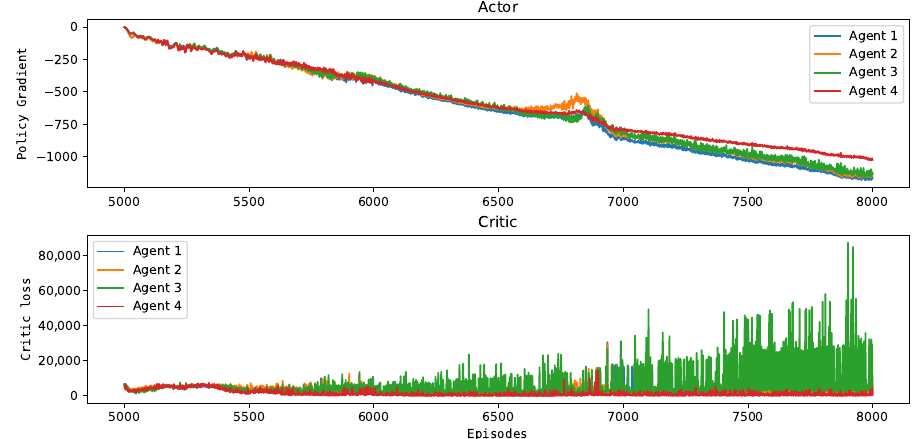
Figure 8. Actor and critic update to Van de Vusse reactor economic optimization and